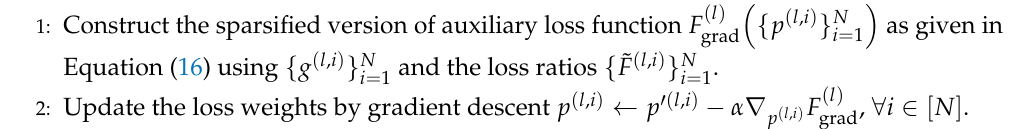
Algorithm 4 FGN_Server